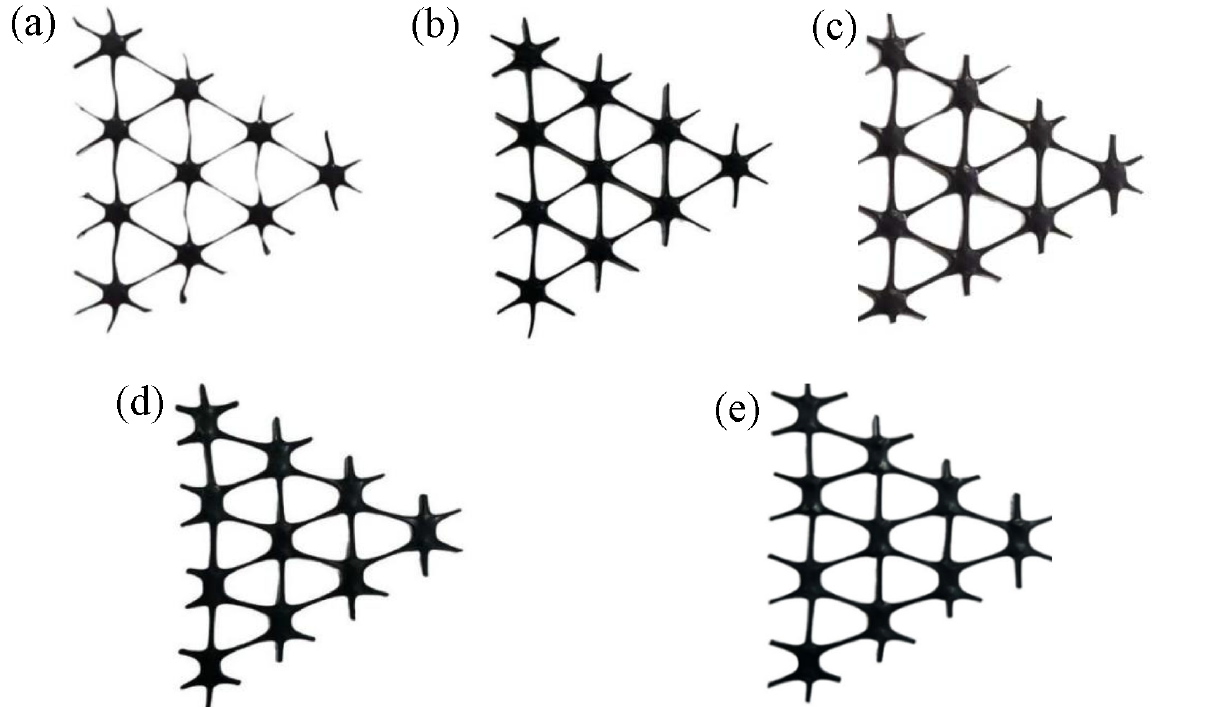
Figure 4. Circular pre-punched industrial PP triaxial geogrid with different diameters. ( a ) D = 4.0 mm, ( b ) D = 3.5 mm, ( c ) D = 3.0 mm, ( d ) D = 2.5 mm, ( e ) D = 2.5 mm.